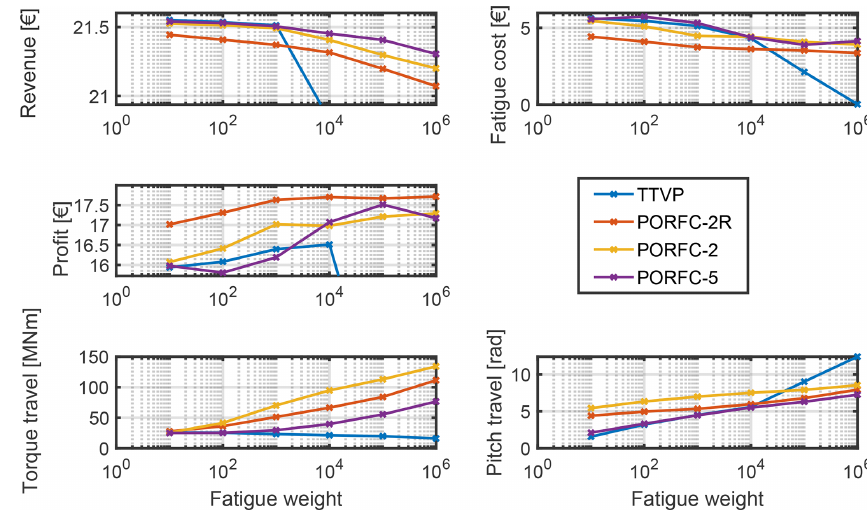
Figure 10. Variation in KPIs for different fatigue weights and a prediction horizon length of T horiz = 8s. Table 3. Optimum fatigue cost weights α fatigue for different controller formulations and prediction horizon